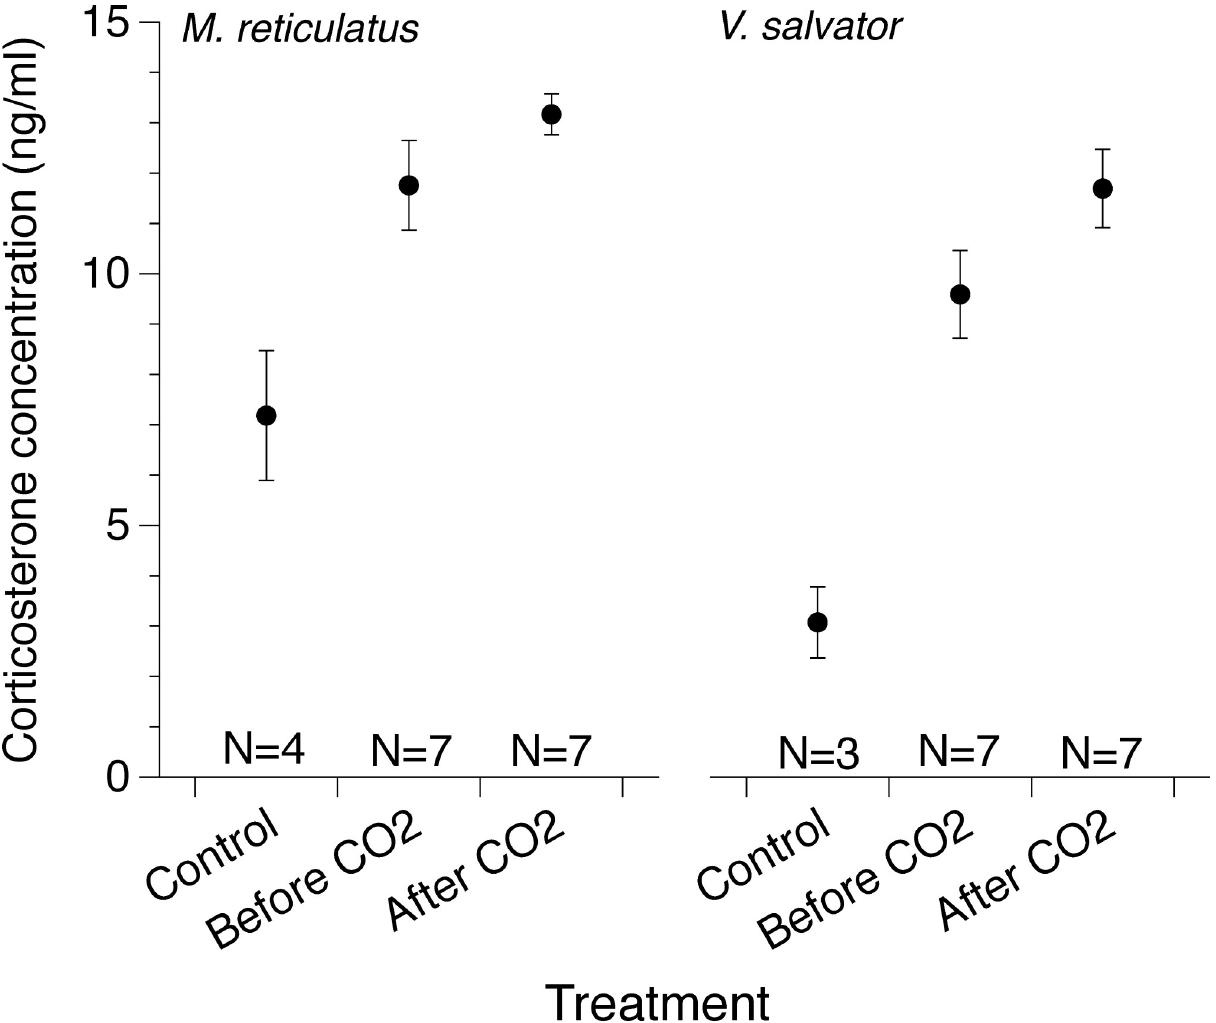
Fig 3. Mean plasma corticosterone concentrations (ng/ml) before and after 15 minutes of CO 2 exposure and in control specimens (free-ranging or farmed; see text) of (a) Malayopython reticulatus and (b) Varanus salvator . Differences between corticosterone concentrations before and after CO 2 exposure were not statistically significant for M . reticulatus , but were for V . salvator . Corticosterone concentrations between control specimens not subject to capture and handling are significantly lower than those captured from the wild for trade (although sample sizes were low; see text for details). Sample sizes for each group are reported directly above the